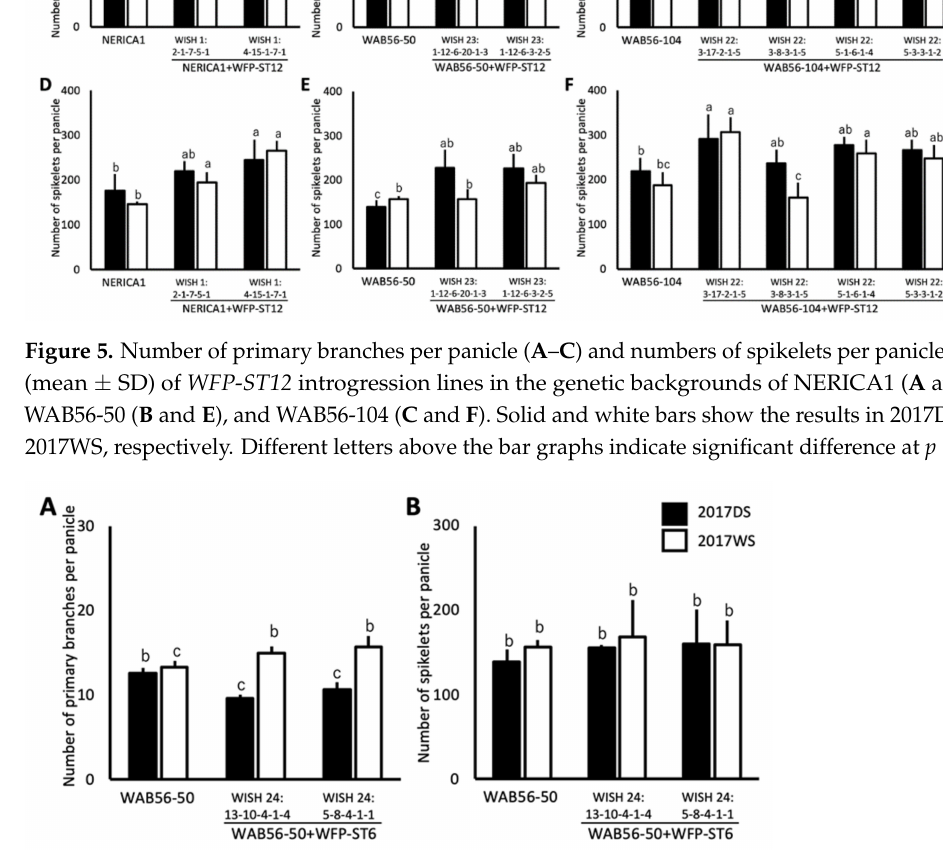
Figure 6. Number of primary branches per panicle ( A ) and numbers of spikelets per panicle ( B ) (mean ± SD) of WFP-ST6 introgression lines in the genetic background of WAB56-50. Solid and white bars show the results in 2017DS and 2017WS, respectively. Different letters above the bar graphs indicate significant difference at p <